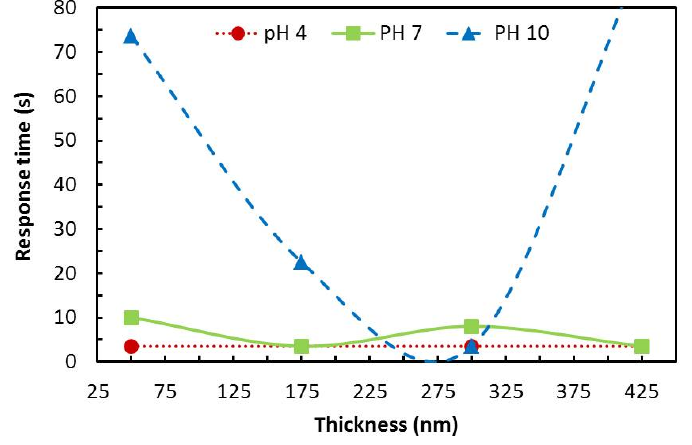
Figure 4. Measured response time versus sensing film thickness for test solutions of different pH values. Reprint with permission from [21]. Copyright 2014 Elsevier.